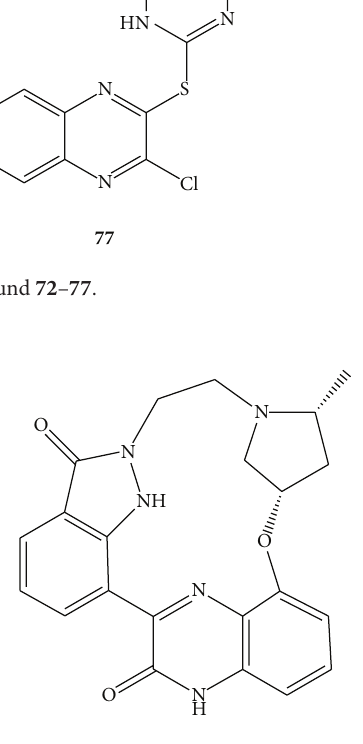
Figure 31: Chemical structure of compound 79